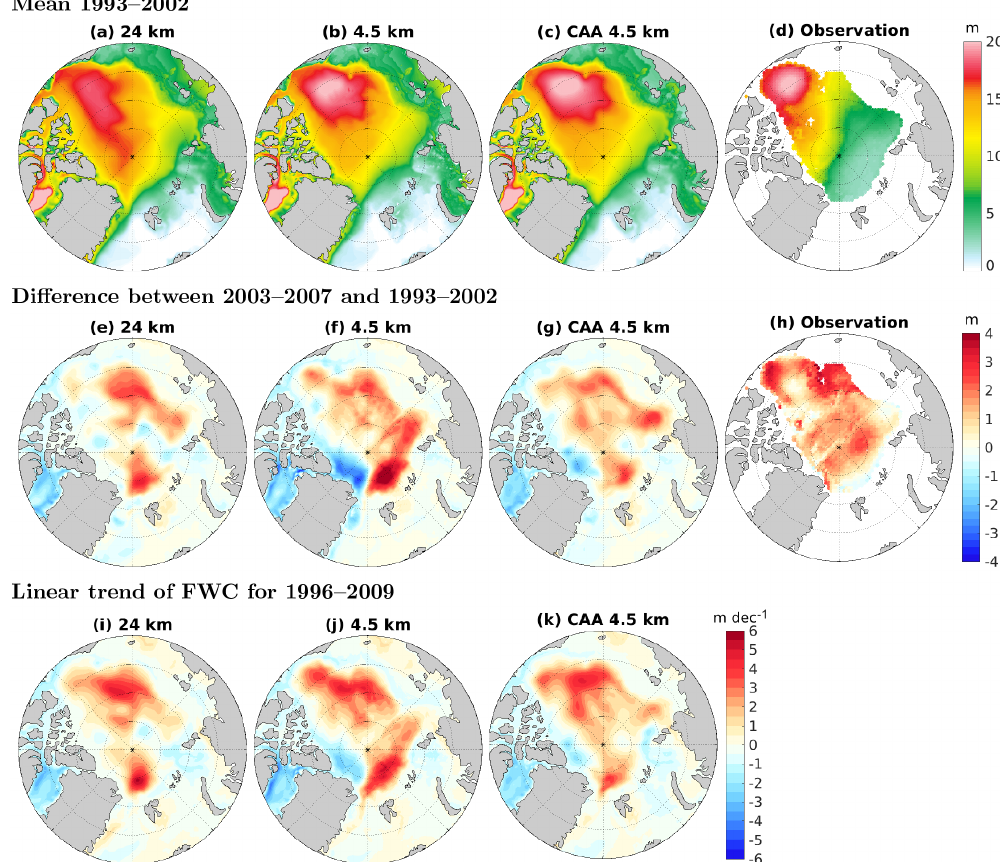
Figure 10. Mean liquid FW content (in meters) for the period of 1993–2002 for (a) LOW, (b) HIGH, (c) HIGH-CAA, and (d) observation of Rabe et al. (2011). Difference in liquid FW content between the periods 2003–2007 and 1993–2002 for (e) LOW, (f) HIGH, (g) HIGH- CAA, and (h) observation. These two periods are chosen to be the same as those used by Wang et al. (2016b) for the convenience of direct comparison. Linear trend of FW content (mdecade − 1 ) for the period of increasing FW content (1996–2009; see Fig. 9a) for (i) LOW, (j) HIGH, and (k) HIGH-CAA. The FW content is calculated using a reference salinity of 34.8. The sensitivity experiment HIGH-CAA is introduced to isolate the impact of resolution in the CAA from that in the Arctic interior. It has 4.5km resolution (the resolution in HIGH) only inside the CAA straits and 24km resolution (the resolution in LOW) in other parts of the Arctic